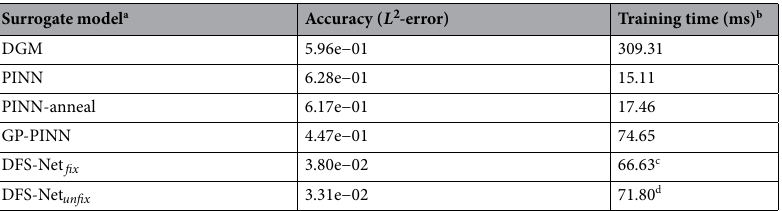
Table 5. Comparison of the relative L 2 -error of different neural network-based surrogate models on the lid- driven cavity flow benchmark ( Re = 300 ). a All models consists of three hidden layers with 128 neurons in each layer. b The training time for each Adam epoch. c The training time of DFS-Net fix for each L-BFGS-B epoch is 280.56 ms. d The training time of DFS-Net unfix for each L-BFGS-B epoch is 297.83 ms.